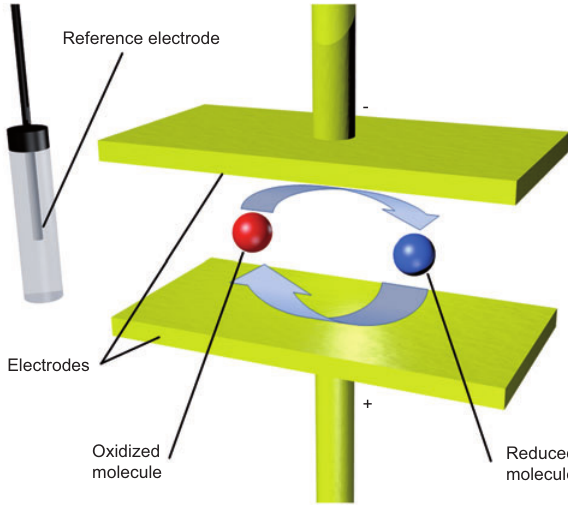
Figure 1 Illustration of the redox cycling mechanism. The sketch depicts the oxidizing and the reducing electrode as well as a refer- ence electrode. Redox-active molecules are indicated by the two spheres, while the red and the blue colorings represent the oxidized and reduced molecule states,